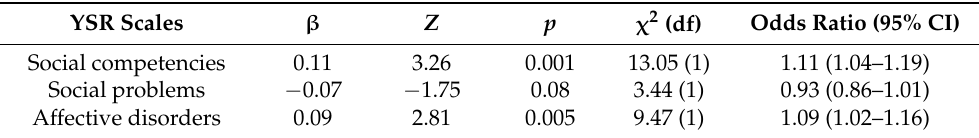
Table 3. Results of the binomial logistic regression considering the NSSI onset (past vs. recent) as a dependent